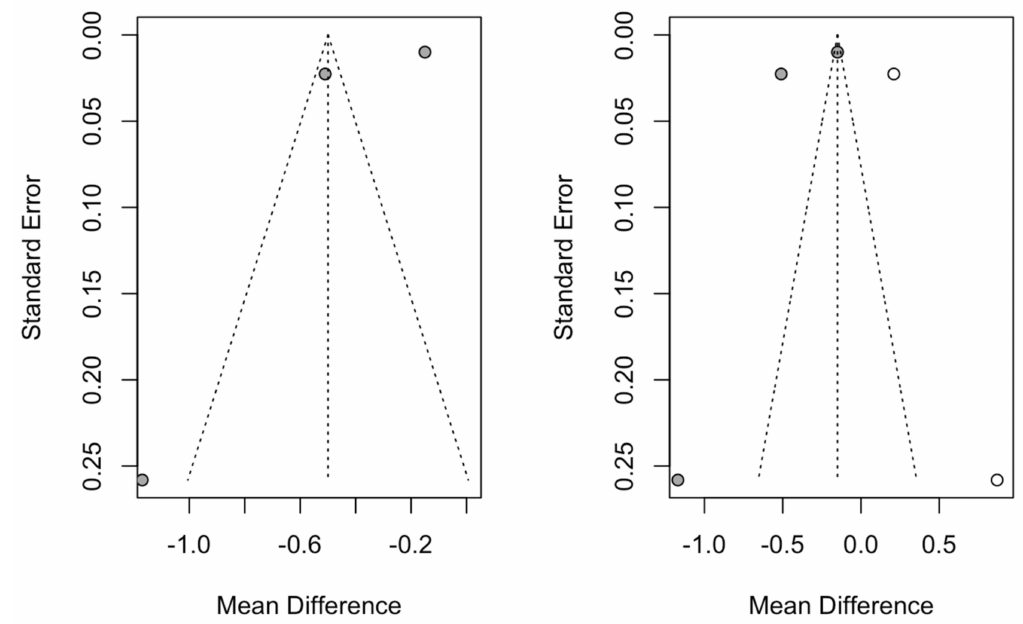
Figure 6. Initial funnel plot and plot after trim and fill adjustment of the mean difference in bone loss (mm) for the immediate dental implant placement in the esthetic zone using the socket-shield technique.